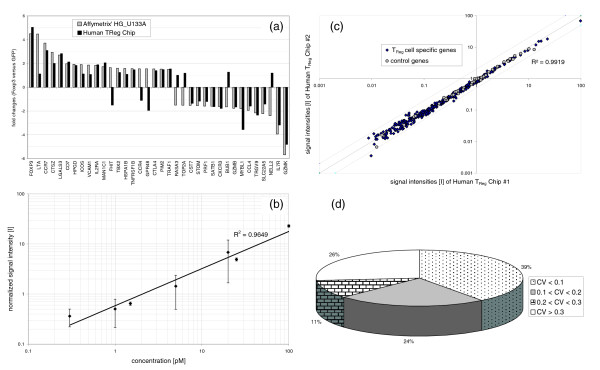
Performance of the Human TReg Chip. (a) Comparability to Affymetrix. Splitted samples (FOXP3 or GFP transfected T cells) were hybridized to Affymetrix HG_U133A microarrays and Human TReg Chips, respectively. Differentially expressed genes on the Affymetrix platform (regulation of at least 1.5-fold based on significant signal) were compared with those significant fold changes arising from the Human TReg Chip platform. As demonstrated, 29 out of 36 genes exhibited similar regulation on the Human TReg Chip compared with Affymetrix, resulting in a correlation of 81%. (b) Hybridization controls. Normalized signal intensities versus concentration of used hybridization controls are plotted as means of 5 (1.5 pmol/l, 25 pmol/l and 100 pmol/l) and 59 experiments applying the Human TReg Chip. Standard deviations are indicated by error bars. Linear regression yields a correlation coefficient of >0.96 demonstrating a linear hybridization process covering more than three orders of magnitude of concentrations. (c) Reproducibility of the Human TReg Chip. The same sample was hybridized to several Human TReg Chips. A log-log plot of normalized signal intensities of two example selected slides is illustrated, showing that 99.7% of all signals are located along the bisecting line within the twofold range, reflecting low measurement noise in the data, even for low signal intensities. (d) Coefficients of variation (CV). The ratios of standard deviation and mean were calculated for each gene probed in eight replicates per microarray. CVs of all 59 experiments applying the Human TReg Chip contributing to the expression profile of human TReg cells are presented as means. As demonstrated, 73% of all signals have a CV below 0.3.